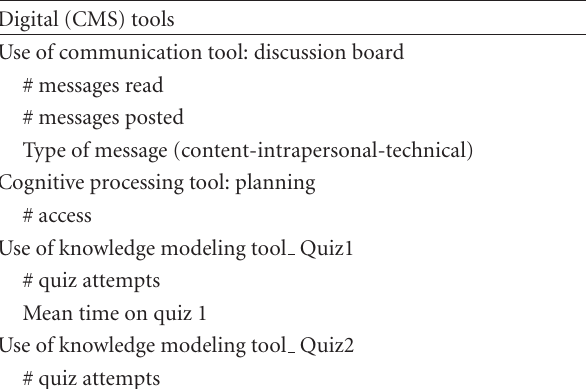
Table 2: Tool-use